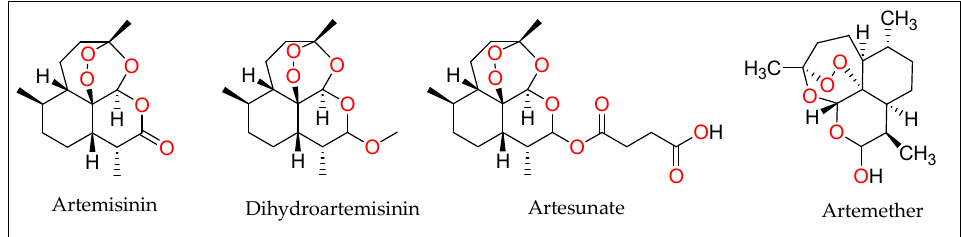
Figure 9. Artesunates with anticancer activity.